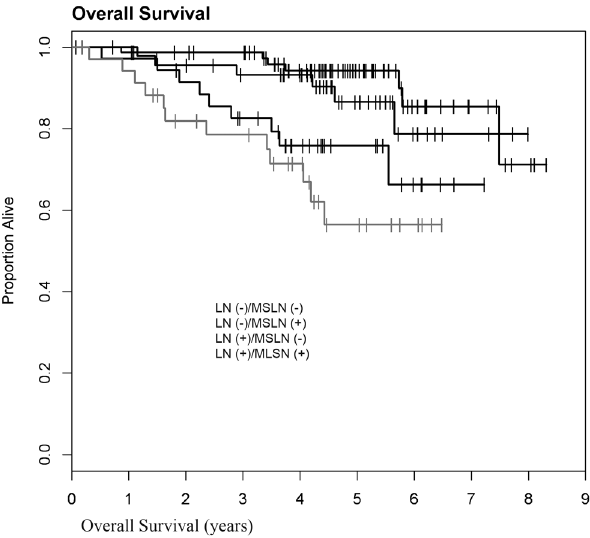
Fig. 5. The difference in overall survival for MSLN( + ) TNBC is independent of lymph node (LN) status (log rank p 5 0.0003, n 5 188).